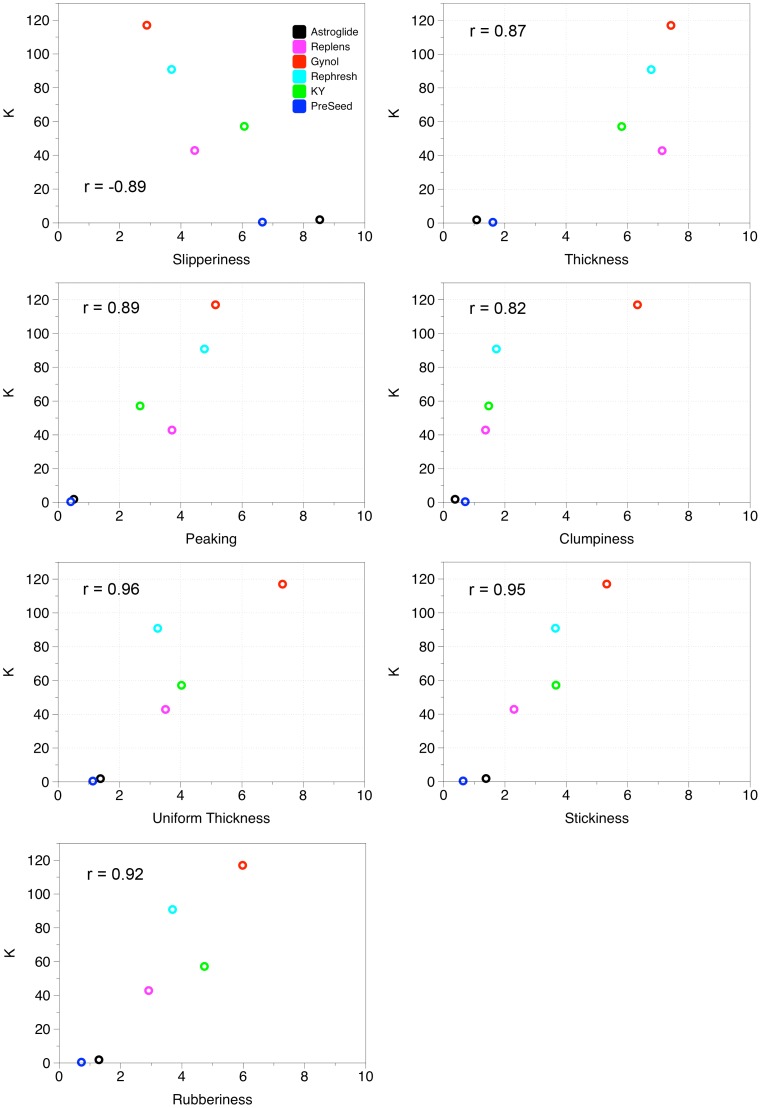
Shear storage modulus, G’, loss modulus, G” and tangent delta of samples over the frequency range 1–100 rad/s at 5% strain.Within each plot, G’ and G’’ are plotted on the left y-axis and tan delta is plotted on the right y-axis. To provide better resolution, the range differs for the left y-axis for the bottom two figures.